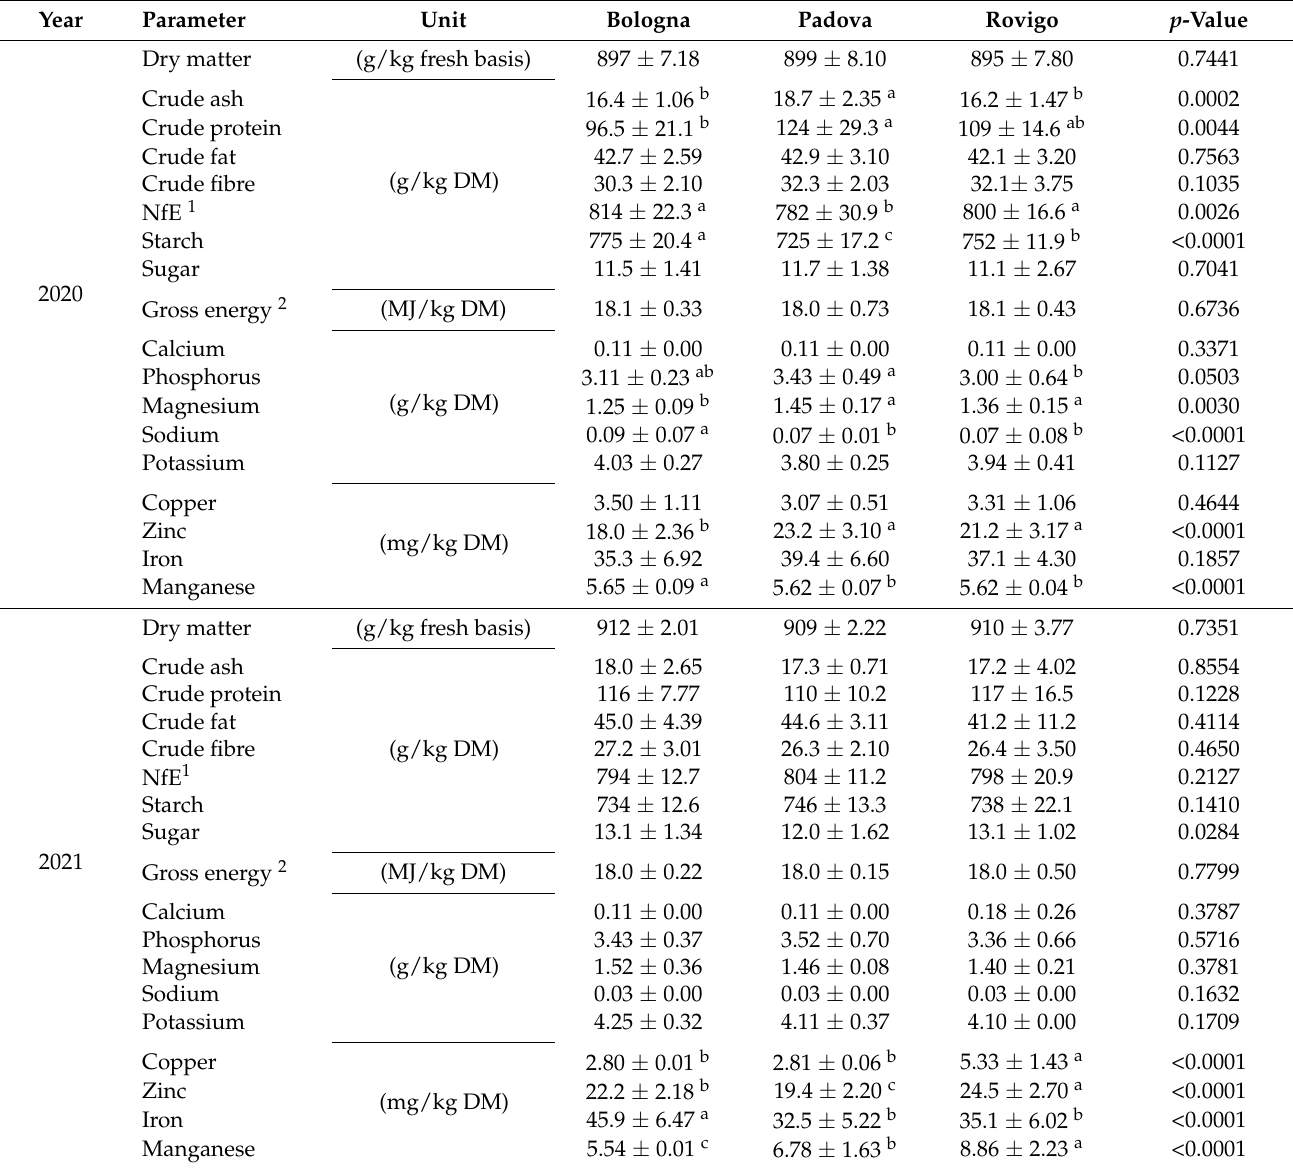
Table 1. Chemical composition of sorghum samples from different locations and years ( n = 15 per location and year; mean ± SD).